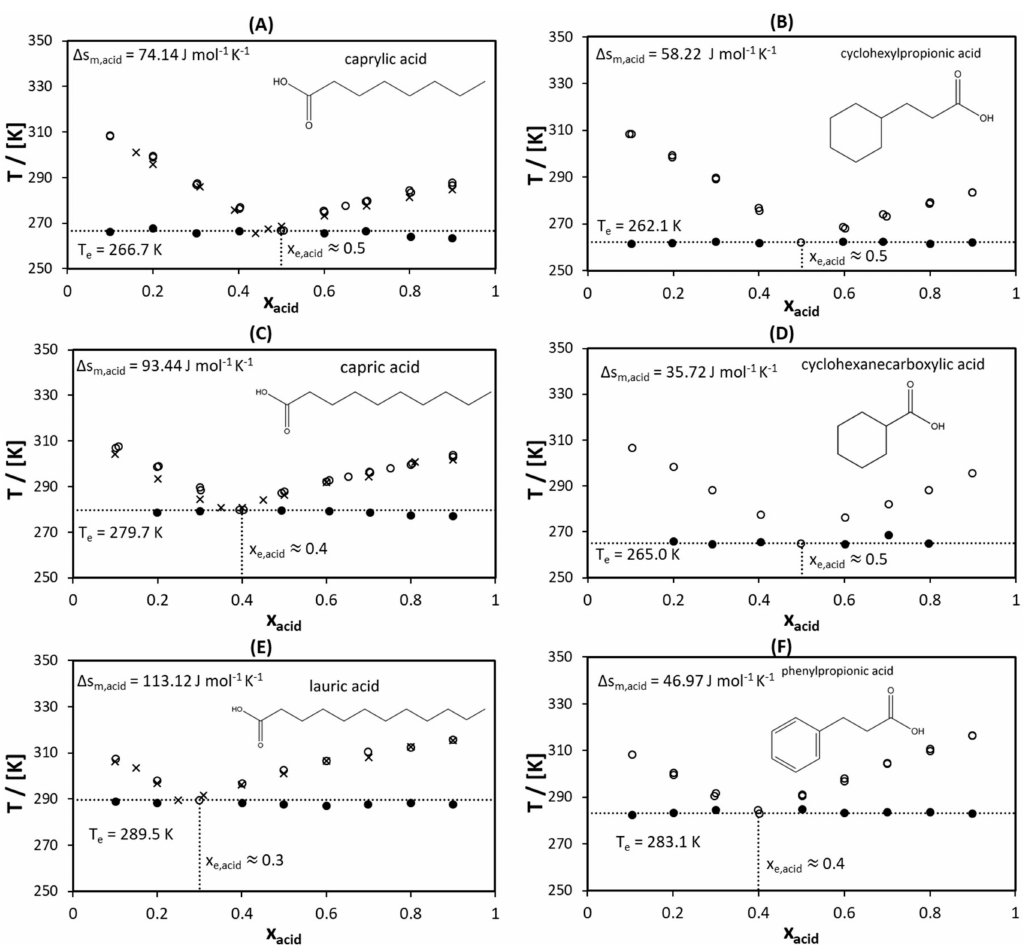
Figure 2. Solid–liquid phase diagrams of binary eutectic mixtures consisting of l -menthol and ( A ) caprylic acid, ( B ) cyclohexylpropionic acid, ( C ) capric acid, ( D ) cyclohexanecarboxylic acid, ( E ) lauric acid, and ( F ) phenylpropionic acid. The melting properties presented are experimentally determined values. Legend: ◦ liquidus temperature measured in this study, • the experimental eutectic temperature measured in this study, × Martins et al.